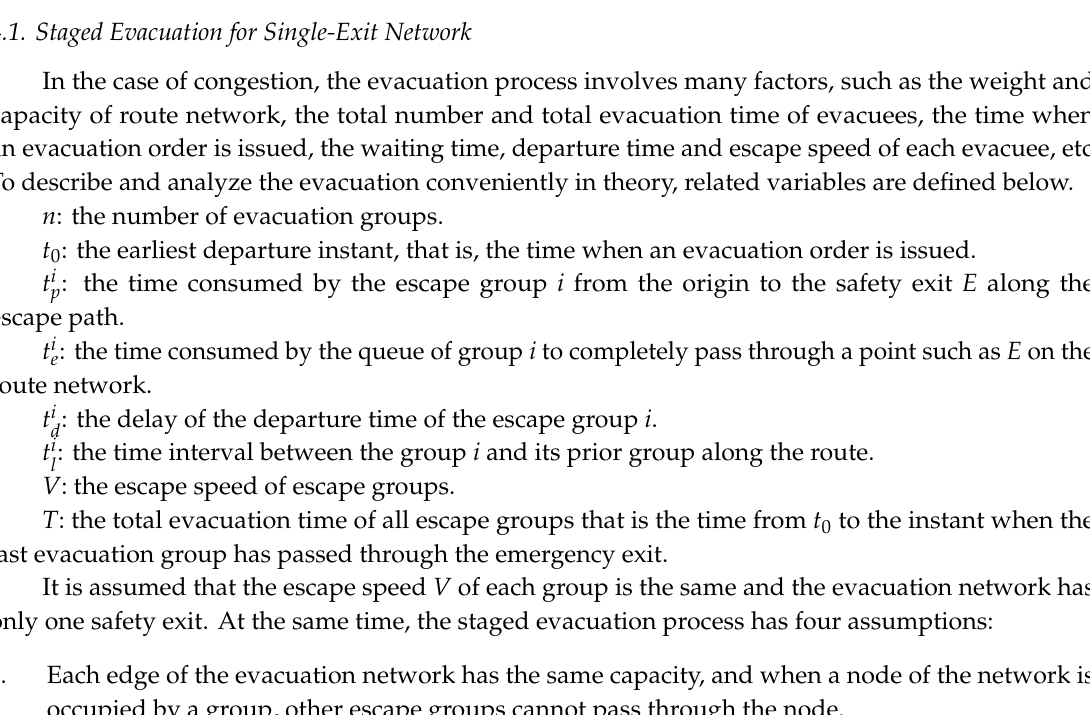
Figure 2. Transformation from the multi-exit route network to several single-exit route networks. ( a ) The multi-exit route network; ( b ) The partitioned multi-exit route network.